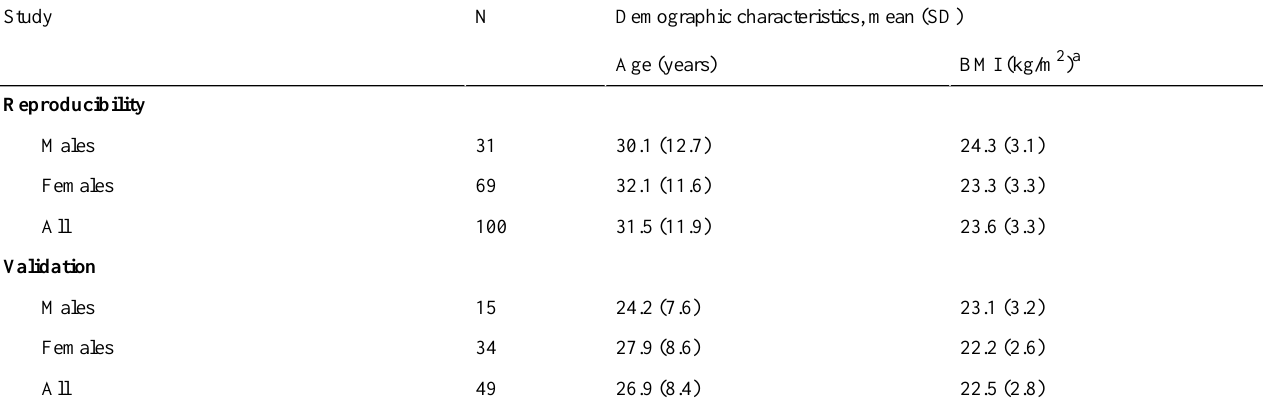
Table 1. Demographic characteristics of the participants who completed the validation and reproducibility studies according to gender. Demographic characteristics, mean (SD)NStudy